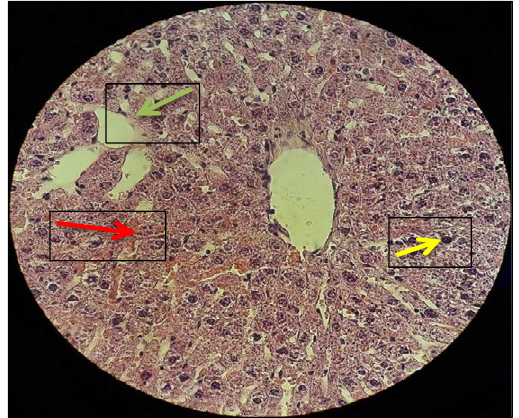
Fig. 7: Photomicrograph of rat liver tissue in experimental group 3. In this group, more severe cell damage was observed compared to other experimental groups. Excessive hemorrhage, necrosis and liver cell congestion were observed (Hematoxylin-Eosin staining, magnification 400×).